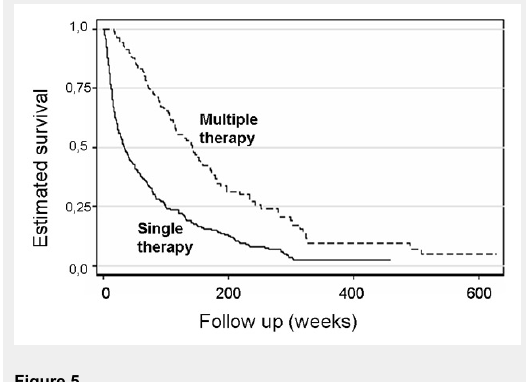
Kaplan-Meier curve for survival of patients with hepatocellular cancer receiving single or multiple therapies (n = 347 and 137 for multiple and single therapy, respectively, p <0.001).